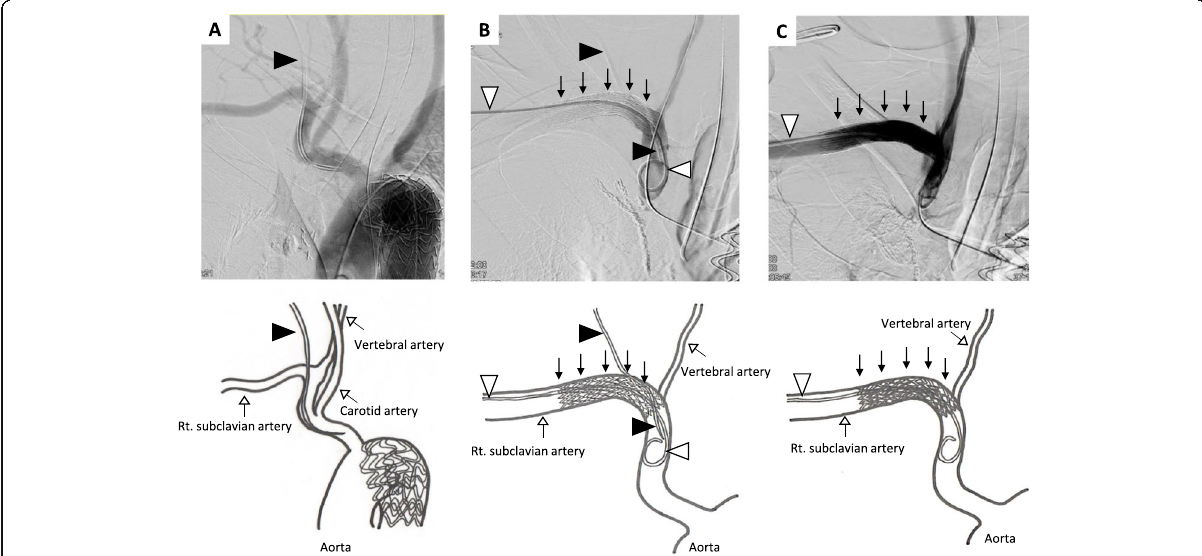
Fig. 1 Angiography. a The catheter was inserted into the artery near the bifurcation of the right vertebral artery and subclavian artery. b An intravascular stent and a guidewire, which was inserted into the right subclavian artery. c An expanded stent and right vertebral artery flow. A black arrow head indicates a central venous catheter migrated into the right subclavian artery. A white arrow head indicates a guidewire for an intravascular stent. Black arrows indicate an intravascular stent. White arrows indicate corresponding